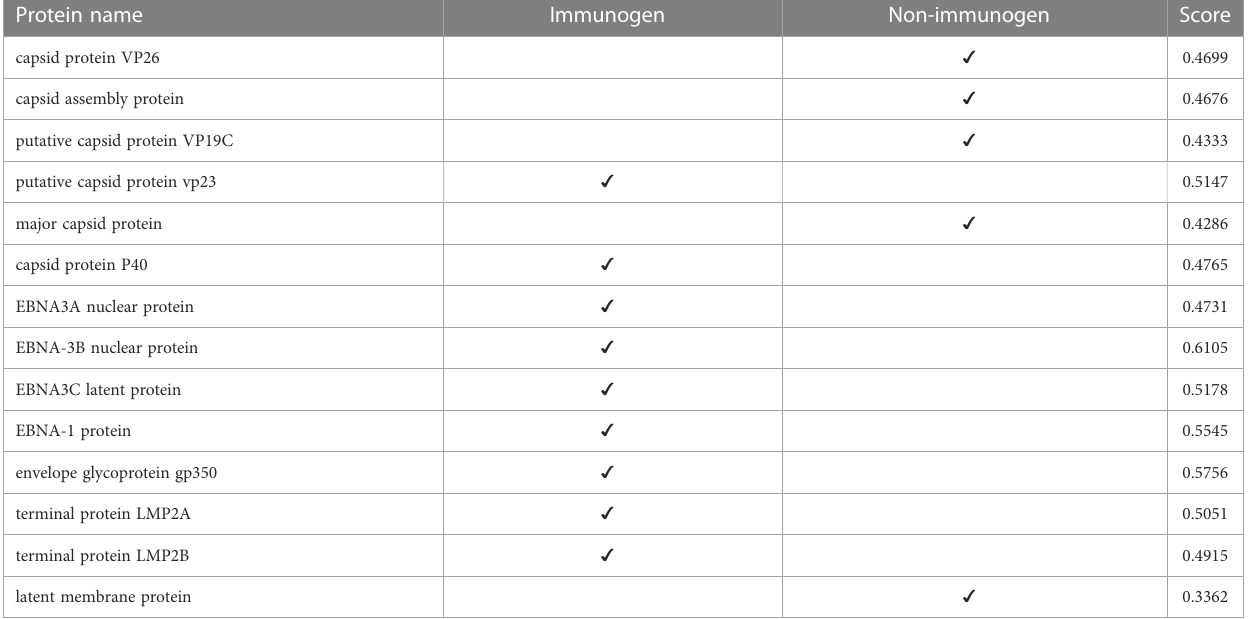
TABLE 4 Immunogenicity of human gammaherpesvirus 4 (strain 1)